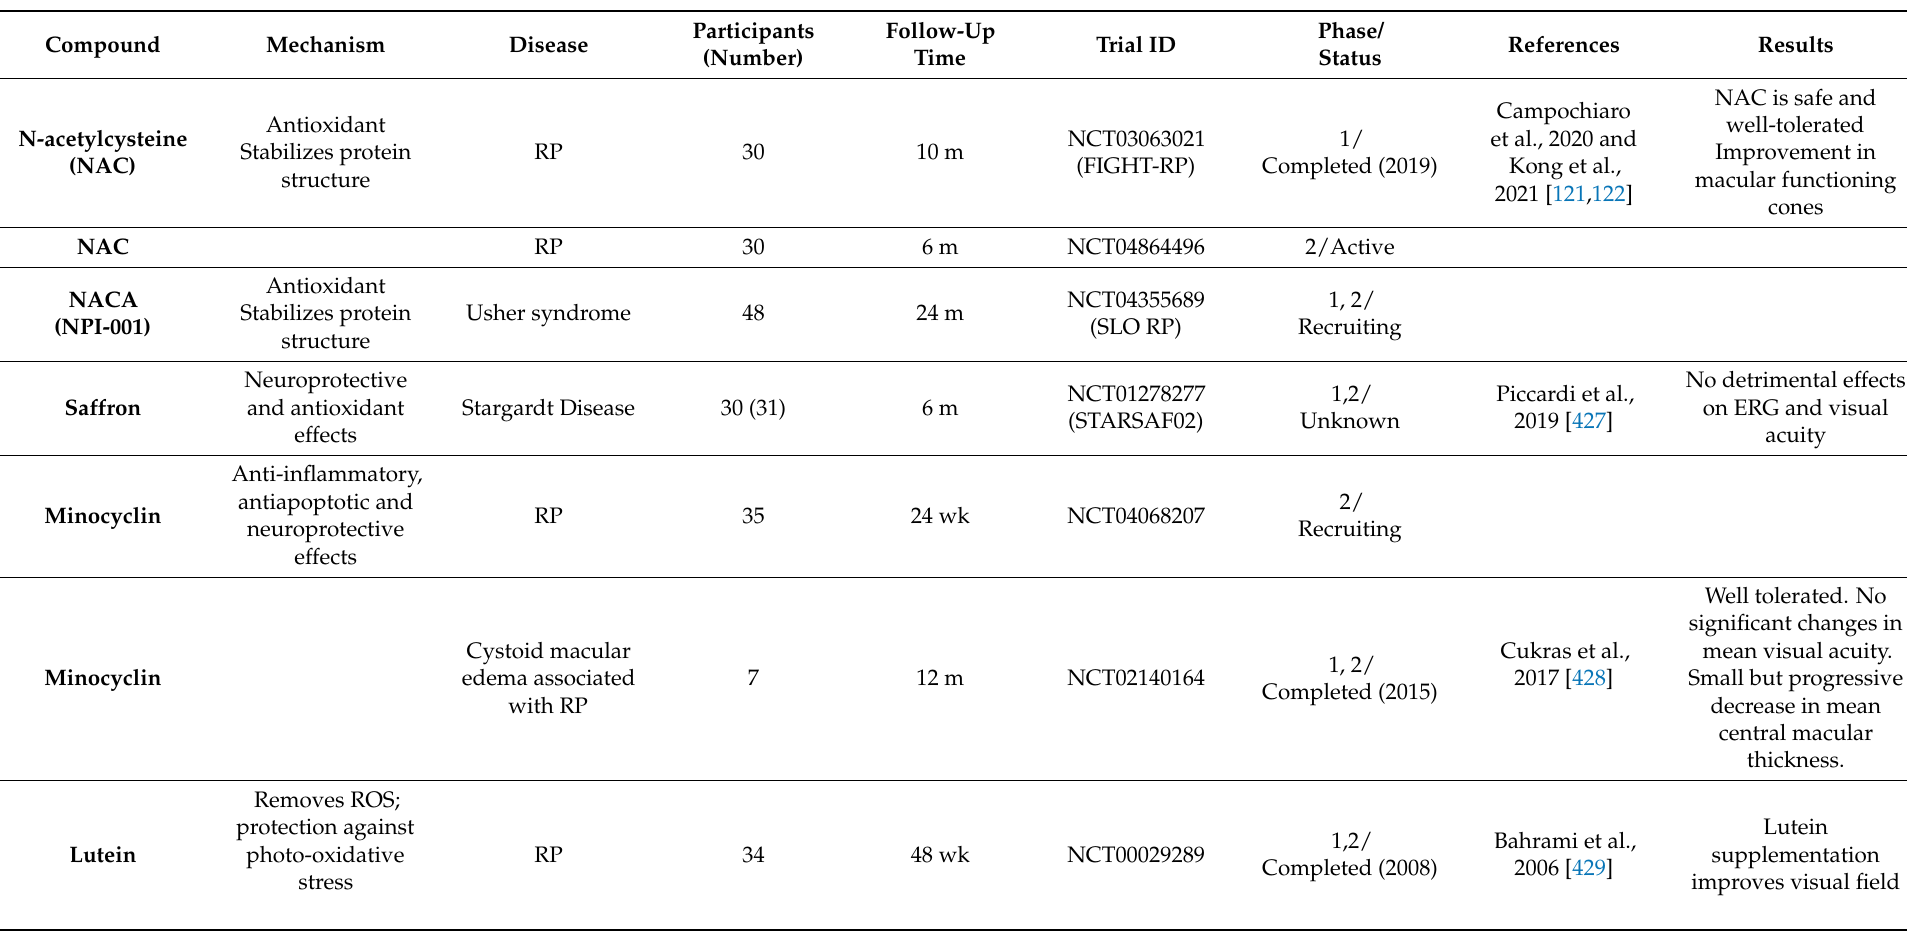
Table 2. Clinical trials in IRD using molecules with antioxidant, antiapoptotic, anti-inflammatory and/or visual cycle modulator